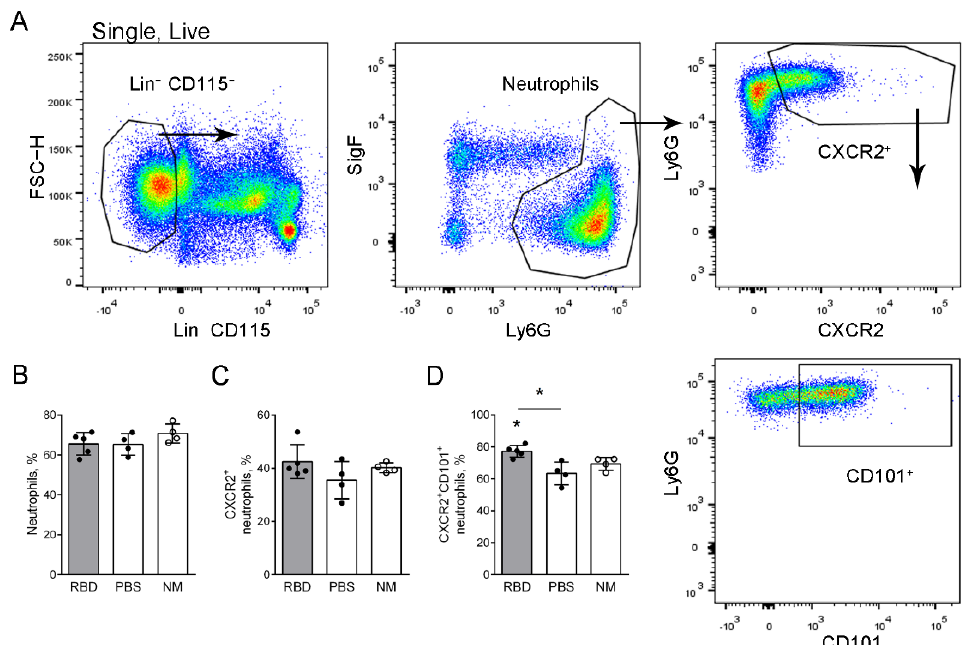
Figure 4. RBD–specific antibody induction effect on the bone marrow neutrophil activation and maturation. ( A ) The strategy of CXCR2 + and CD101 + neutrophil detection in the bone marrow of the mice. ( B – D ) The percentages of neutrophils ( B ), CXCR2 + neutrophils ( C ), and CXCR2 + CD101 + neutrophils ( D ) in the bone marrow of mice that were injected with RBD (gray bars, black circles), PBS (open bars, black circles) 24 h after the application of 100 nm particles in the RBD solution, and intact mice (open bars, open circles). The data are shown as medians and i.q.r. for n ≥ 4 mice per group. A significant difference between the indicated group and the intact mice or between the indicated groups was detected using the Mann–Whitney test *: p ≤ 0.05 .